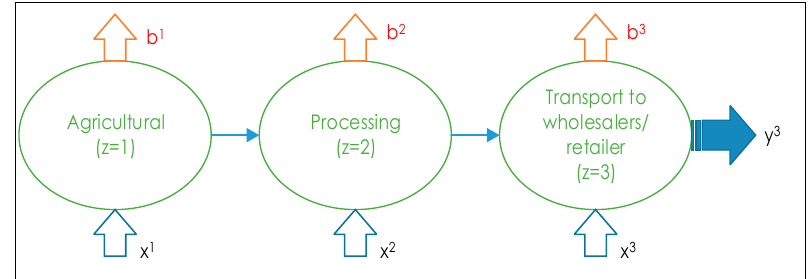
Figure 1. Schematic diagram of an agri-food supply chain.